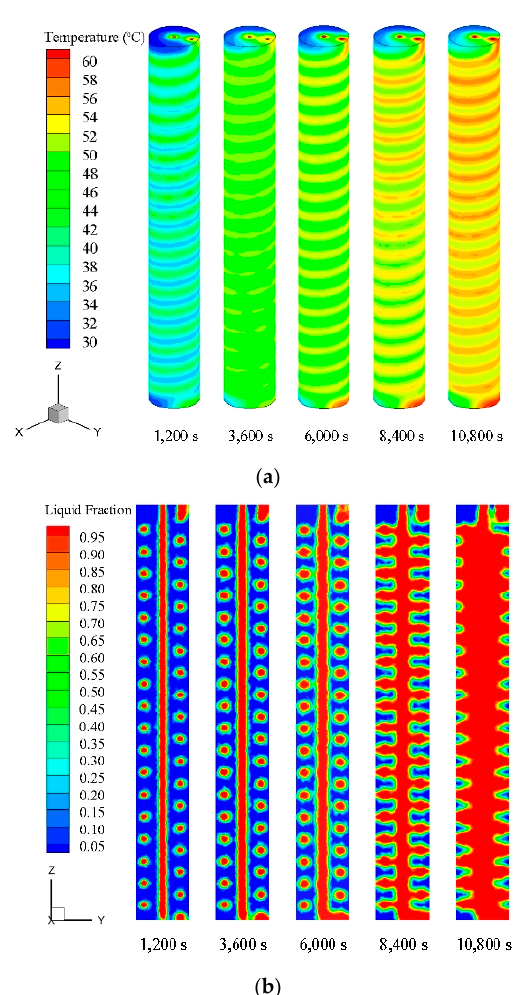
Figure 9. Tempertaure distribtion and liquid fraction of the TES unit over time for Case A. ( a ) Temperature distribution of the outer surface; ( b ) Liquid fraction of the vertical section.